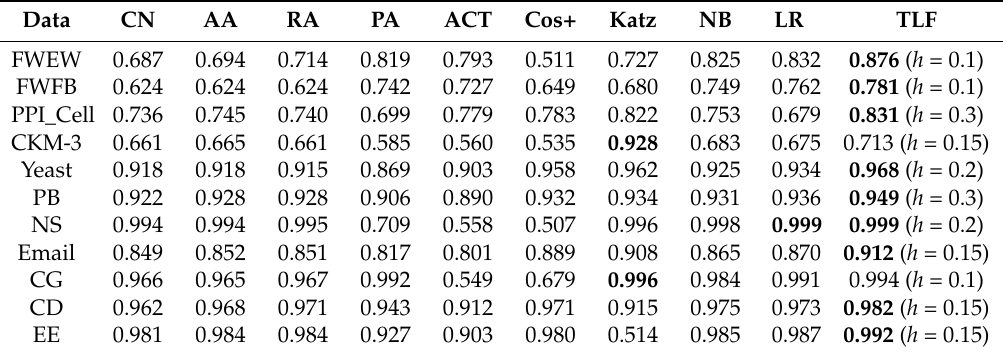
Table 6. Comparisons of the AUC value between TLF and other combination methods or global indices. In each network, the selected window width h is along with the AUC value. The bold figure indicates the best AUC.